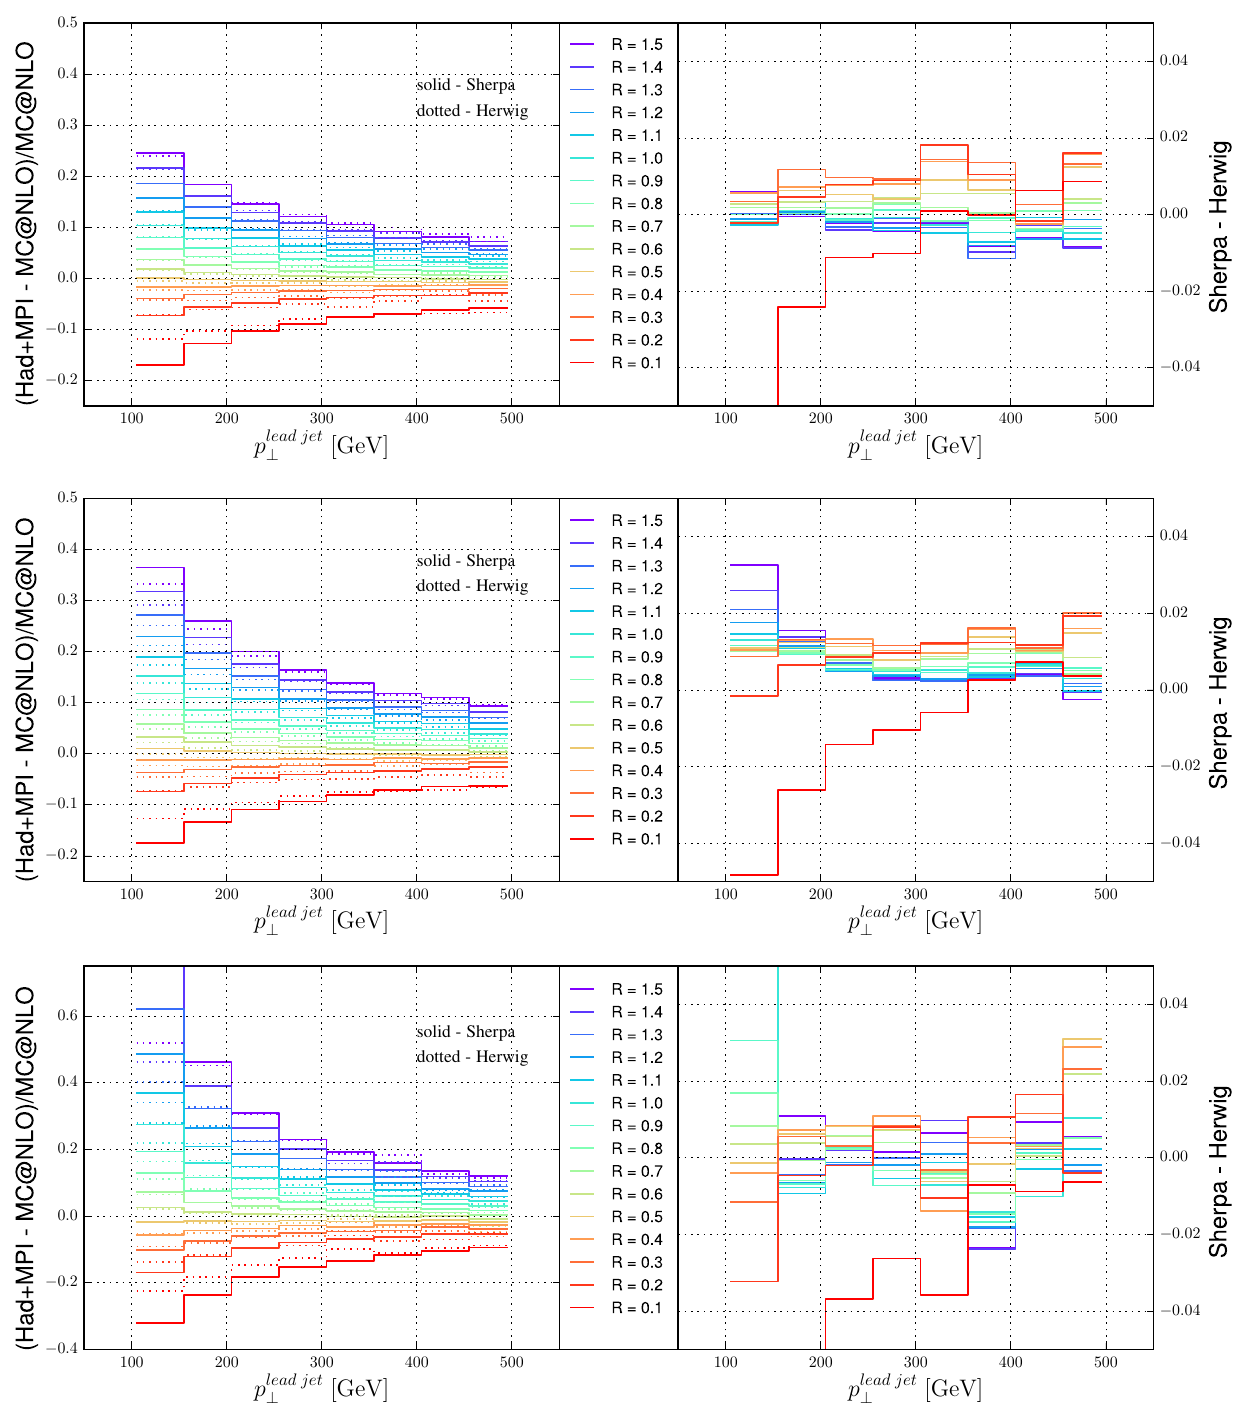
Fig. 20 Hadronization plus MPI corrections for Higgs+jets (top), Z+jets (middle) and inclusive jets